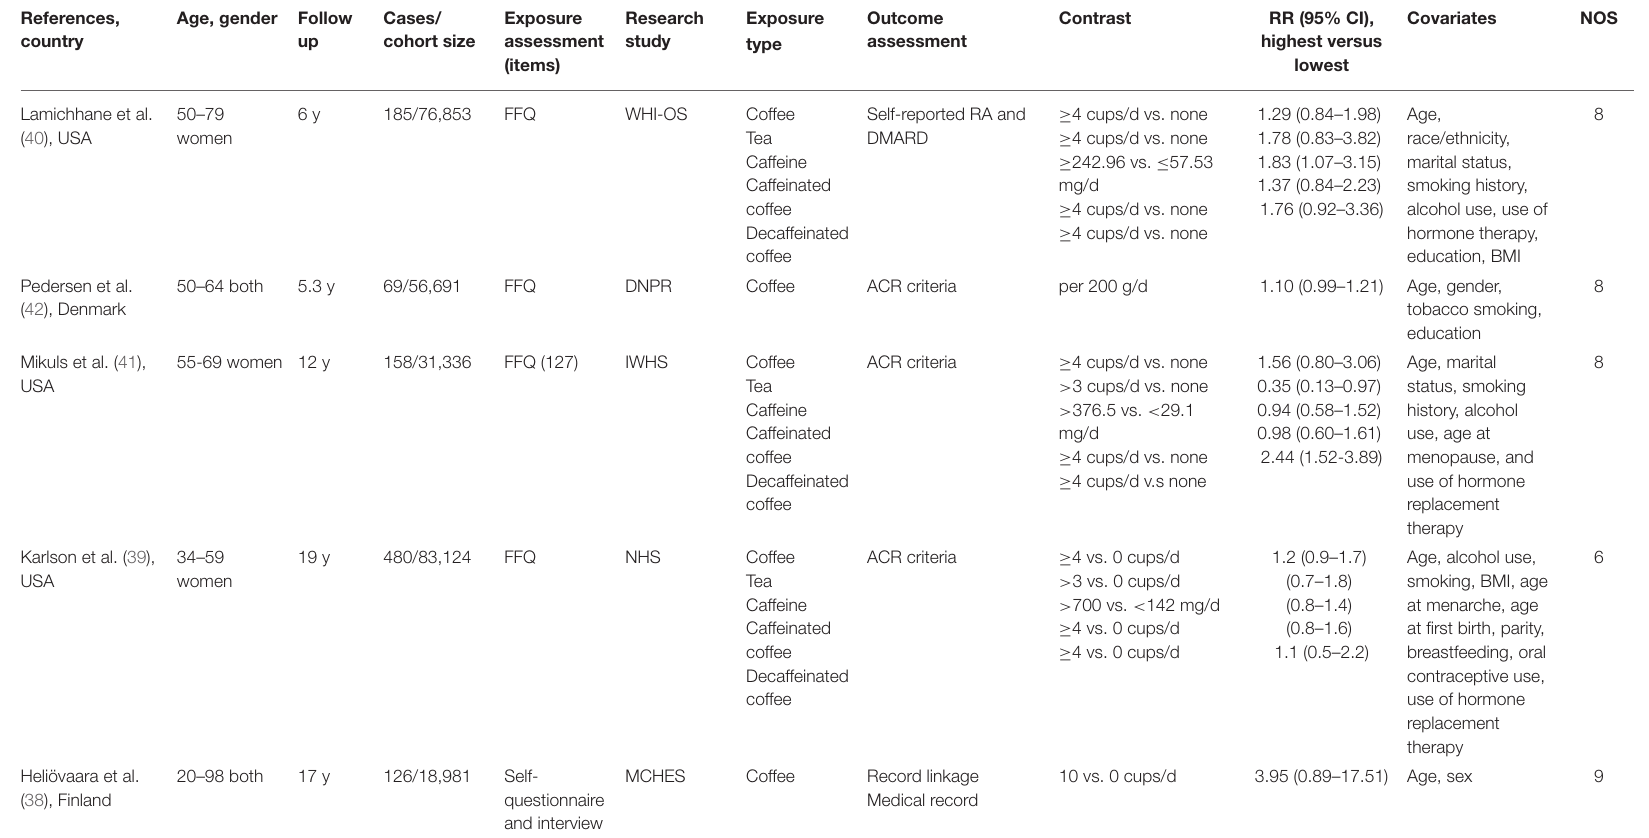
TABLE 1 | Characteristics of included prospective cohort studies.